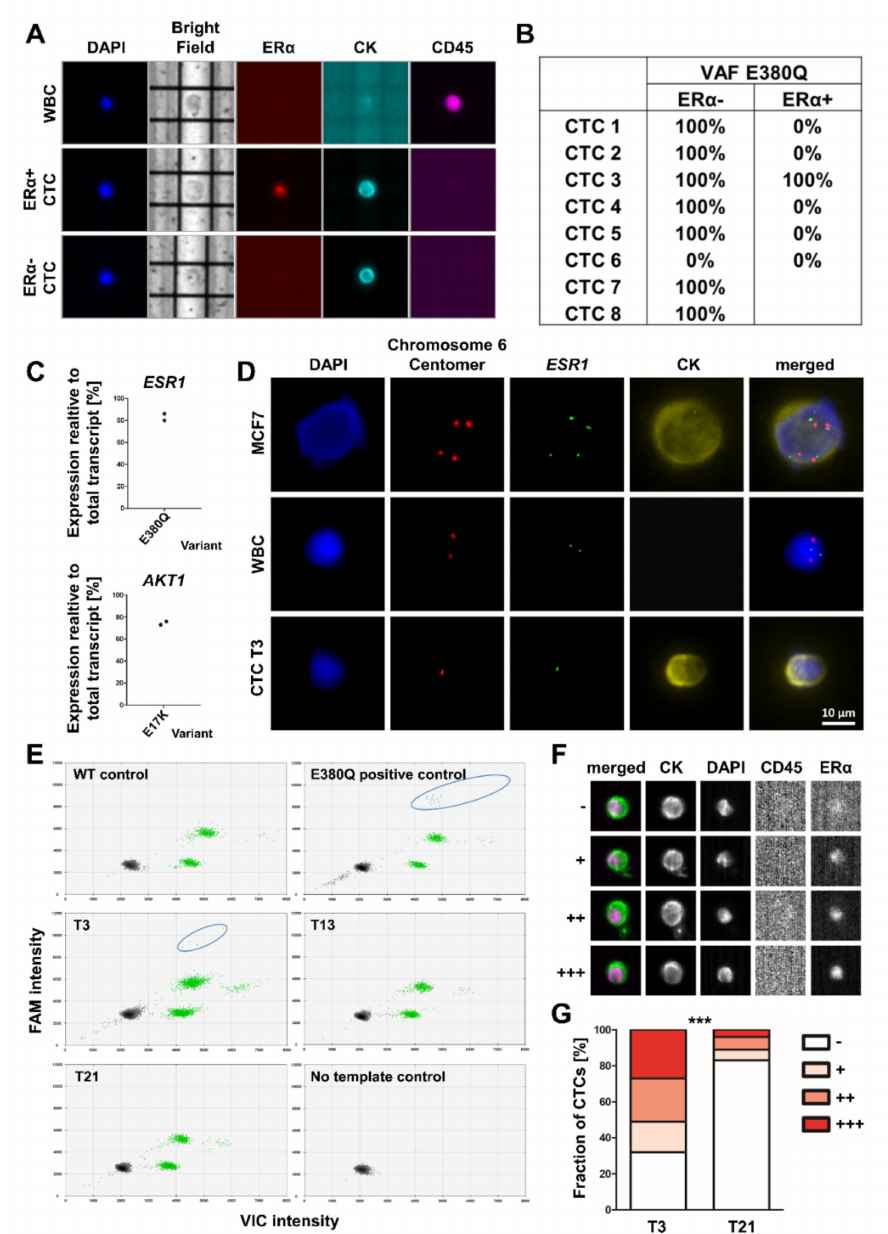
Figure 4. Analysis of ESR1 mutations and ER α expression during the course of the disease of patient 1. ( A , B ) The ESR1 gene from single ER α positive or negative circulating tumor cells (CTCs) from T3 was sequenced (images were generated with the DEParray system; original magnification 10 × ). ( C ) Frequencies of the variant allele on transcriptome level were determined by RNA sequencing of the primary tumor and CTCs from T3 (2 replicates each). ( D ) ESR1 copy numbers determined by fluorescence in situ hybridization. Signals detected with a probe for the ESR1 gene are shown in green. As a reference, a probe for the centromere region of chromosome 6 was used (red). Tumor cells were identified by cytokeratin positivity (original magnification 40 × ). ( E ) ddPCR analysis of ESR1 E380Q mutation in ctDNA. Droplets harboring a mutation are highlighted with circles (blue). ( F , G ) ER α expression analyzed with the CellSearch system. CTCs were classified into four groups based on the ER α staining intensity (images were generated with the CellSearch system; original magnification 10 × ). The statistical significance level was determined by a Fisher’s exact test by comparing ER α -positive (+/++/+++) and ER α -negative CTCs (*** p -value < 0.001). WBC (white blood cell); WT